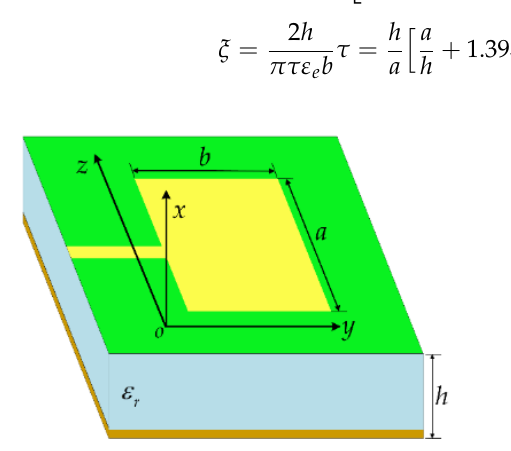
(4) Antenna radiation generates an electromagnetic field with specific performance, and the basic condition for producing electromagnetic radiation is a time-varying current. For the solution of the radiation field of any antenna, only the current distribution on the sur- face of the patch must be known, and the radiation characteristics of the antenna can be obtained by integrating the current element. Therefore, determining the antenna radiated electromagnetic field essentially requires the distributed current on the antenna, but even if the current or voltage of the feed port and the antenna structure are known, it is not easy to determine the current distribution on the antenna, which is an internal antenna problem. To address the difficult distribution of antenna current, combined with the cal- culation model of microstrip antenna resonant frequency derived from the transmission line theory of the microstrip antenna, we believe that if the equivalent length and width of surface current distribution on the microstrip antenna array can be obtained, it is not difficult to calculate the resonant frequency of the antenna, and electromagnetic numerical analysis software can visually display the current distribution on each position of the an- tenna structure. Therefore, based on an analysis of the surface current distribution of the antenna by electromagnetic simulation software, the equivalent length and width of the surface current distribution of the array microstrip antenna can be obtained. Taking a fre- quency reconfigurable antenna (Mode 1 antenna and Mode 2 antenna) as an example, electromagnetic simulation analysis is carried out, and the current distribution is shown in Figure 5.